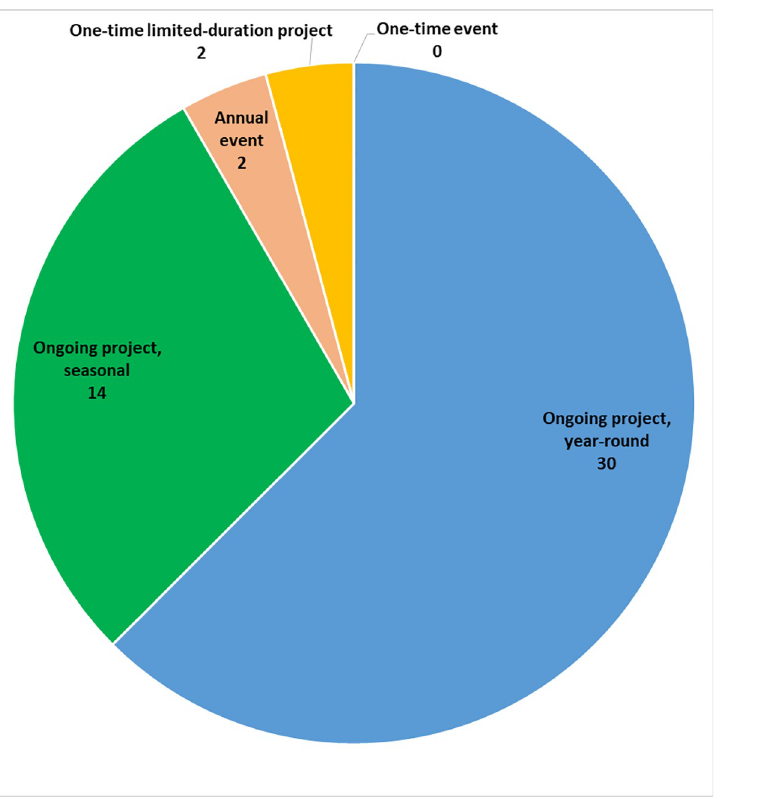
Fig 3. Time frame of participating projects.